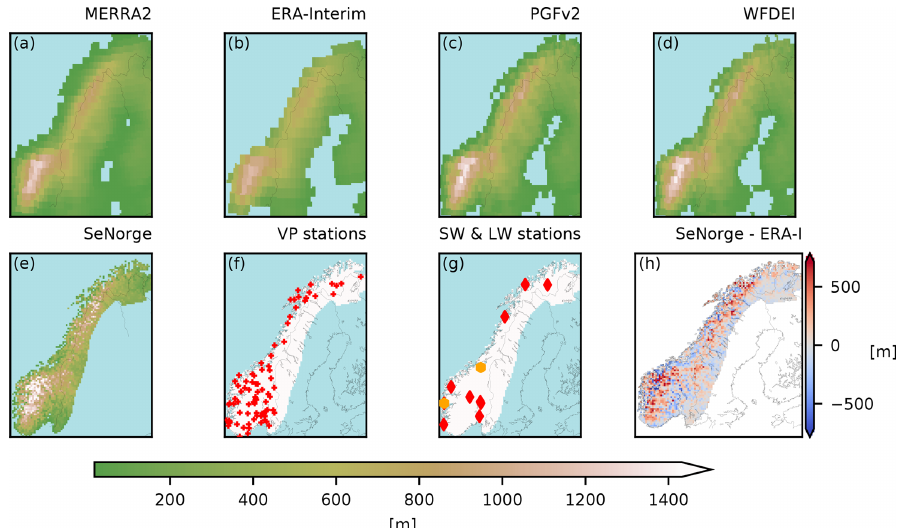
Figure 1. Panels (a) – (e) show the orography and land mask of MERRA2 (a) , ERA-Interim (b) , PGMFDv2 (c) , WFDEI (d) , and SeNorge (c) , respectively, visualized on the SeNorge UTM33 grid with a green–brown color scheme. For reference, national borders and the coastline derived from a high-resolution data set are delineated in black. The locations of the 84 VP stations used in the model comparison are denoted with red crosses in (f) . The locations of SW ↓ and LW ↓ stations are marked in (g) with red and orange markers, respectively. Note that the southernmost LW ↓ station also measures SW ↓ . The last map (h) displays the difference in meters between the SeNorge and ERA-Interim orography in common land areas. Higher elevations in SeNorge are indicated with red, while blue indicates higher elevations in ERA-Interim.